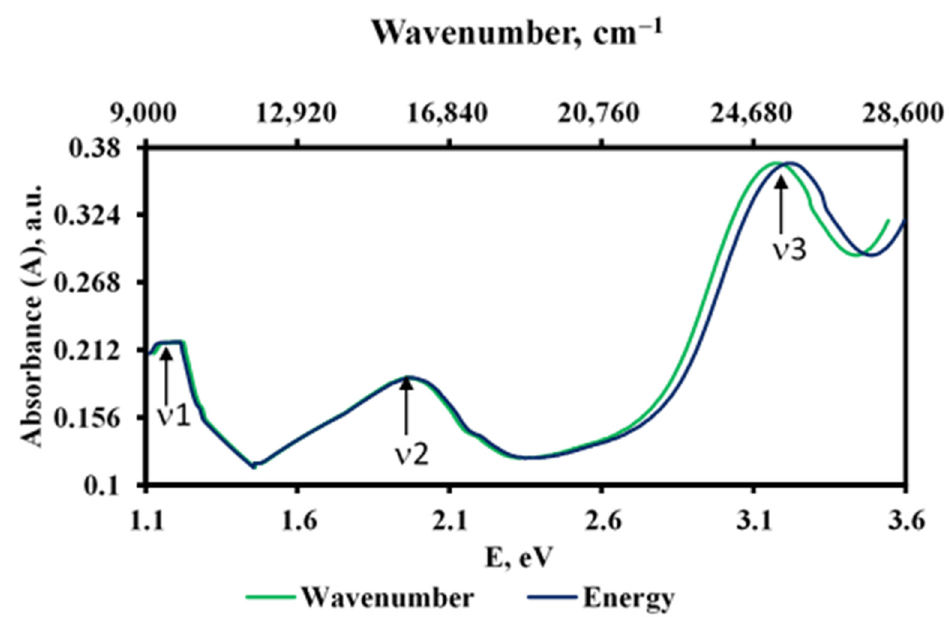
Figure 1. FTIR spectrum of (C 6 H 11 NH 3 ) 4 [Ni(NCS) 6 ] · 2H 2 O.